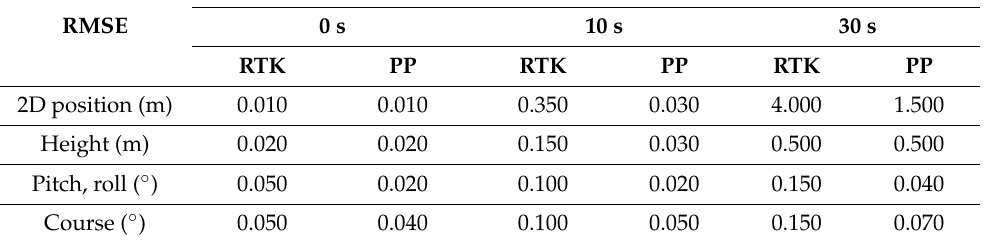
Table 1. Accuracy characteristics of the GNSS/INS system, model Ekinox2-U, by the SBG Systems [65].